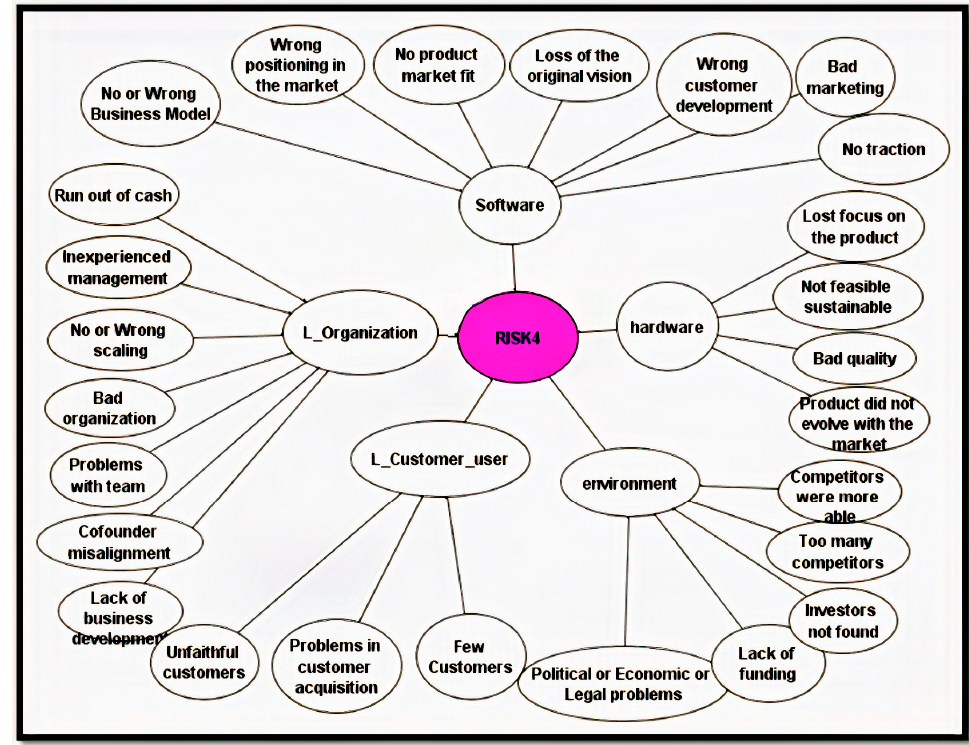
Figure 2. BNs of assessing a start-up default in a lifespan period .